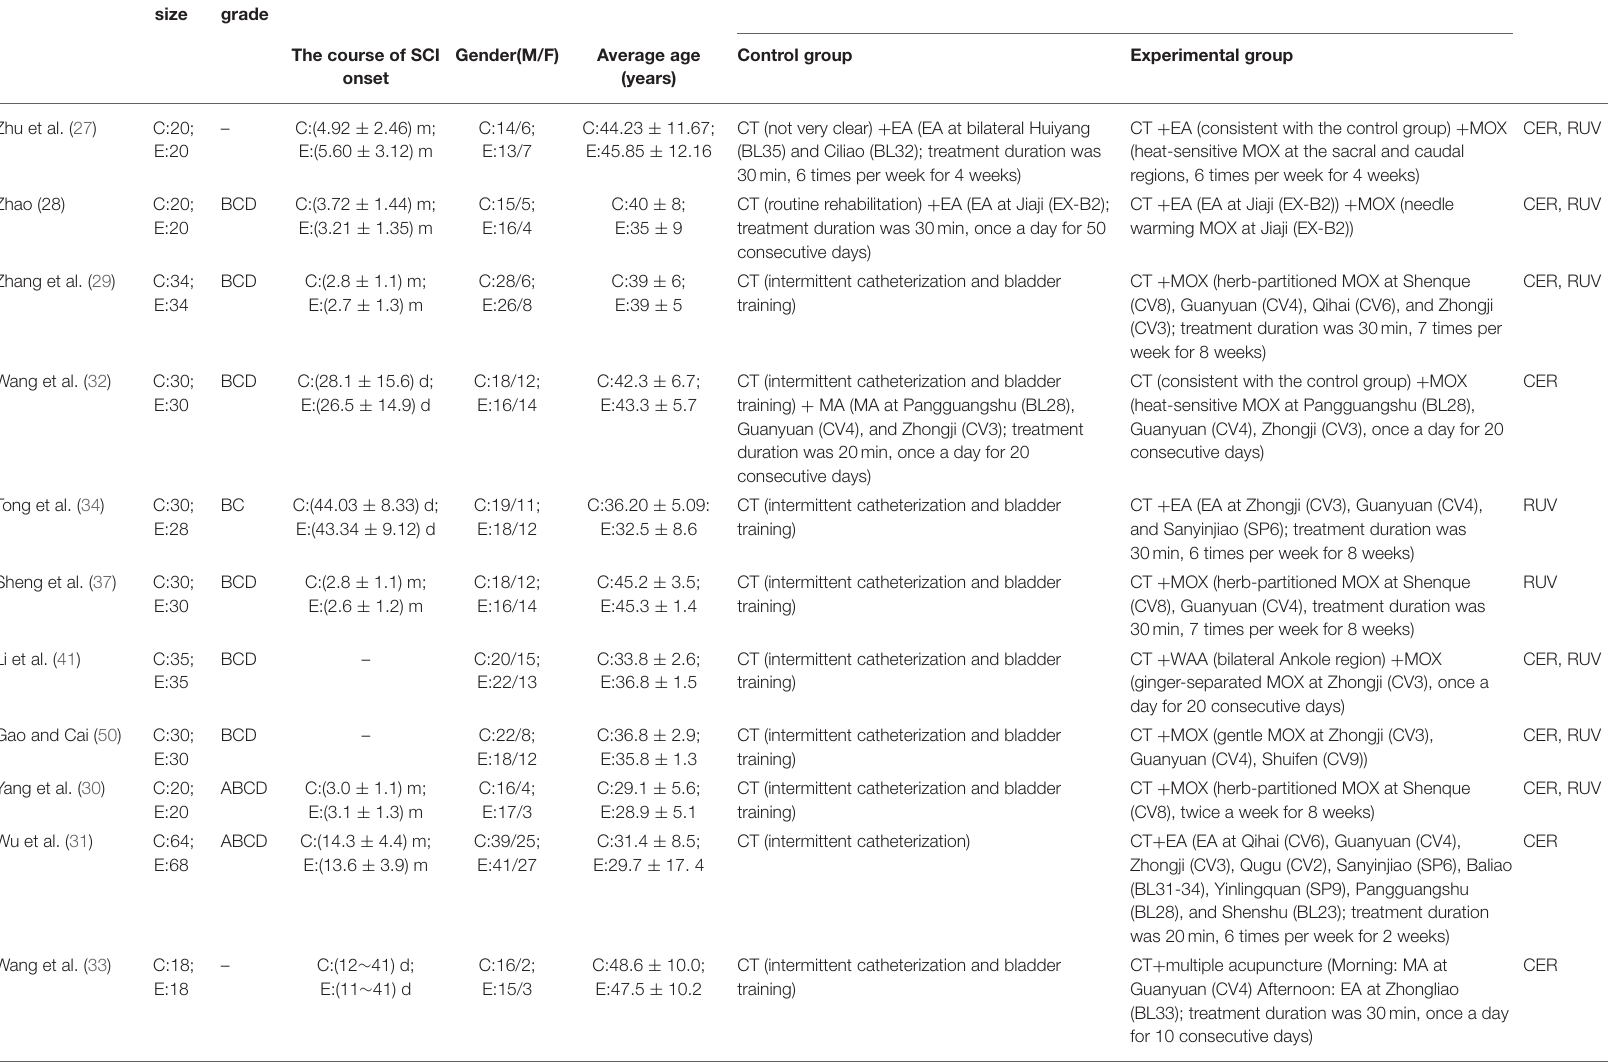
TABLE 1 | Characteristics of the included